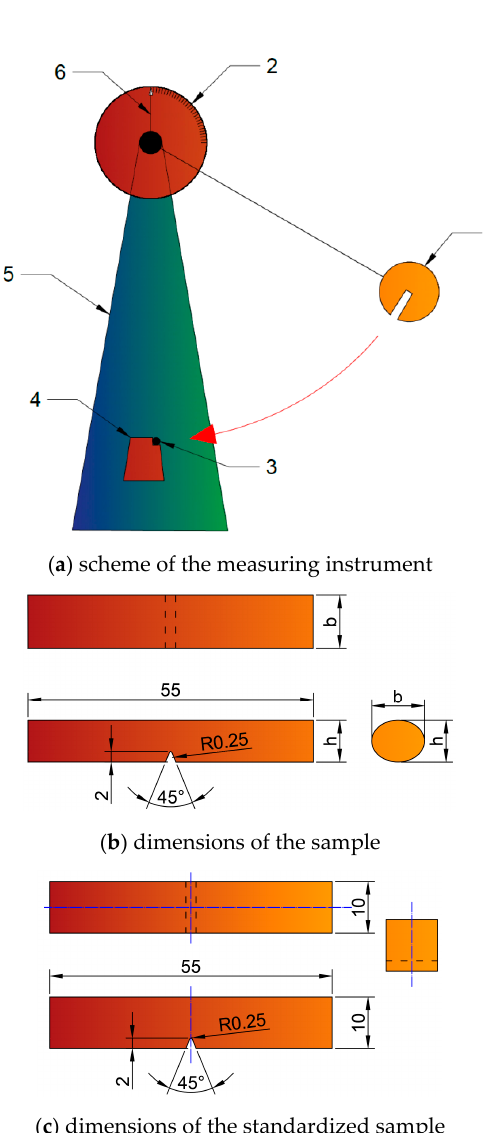
Figure 5. Scheme of the test stand and biomass sample: 1—pendulum, 2—measuring scale, 3—biomass sample, 4—supports, 5—corps, 6—measuring tip, b—width, h—height.